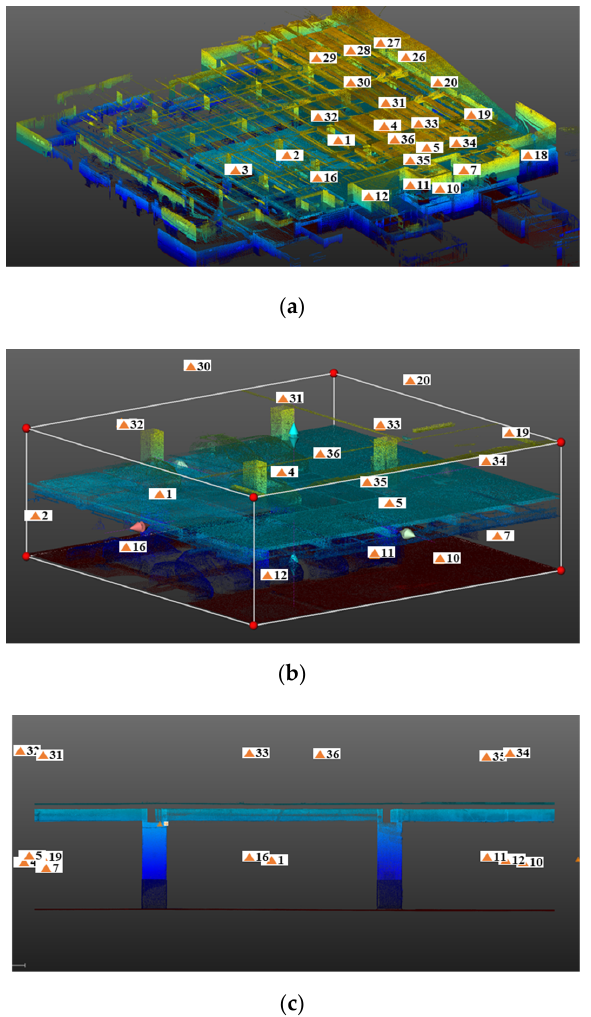
Figure 4. Point cloud data (PCD) by steps: ( a ) Raw data from scan; ( b ) Initial processed data (Auto-Classify); and ( c ) Post-processed data for structural evaluation.